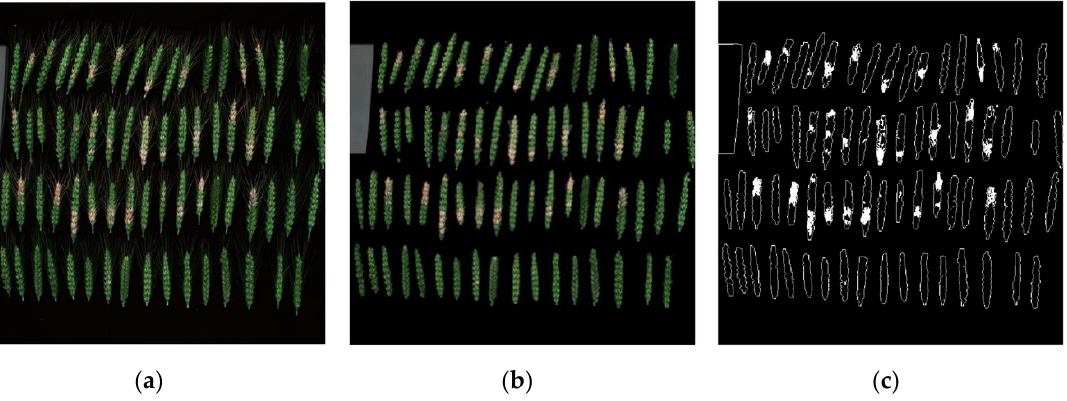
Figure 3. Extraction of diseased spots from wheat ears, ( a ) original image; ( b ) image of wheat tip and stalk removal; ( c ) image of diseased spots